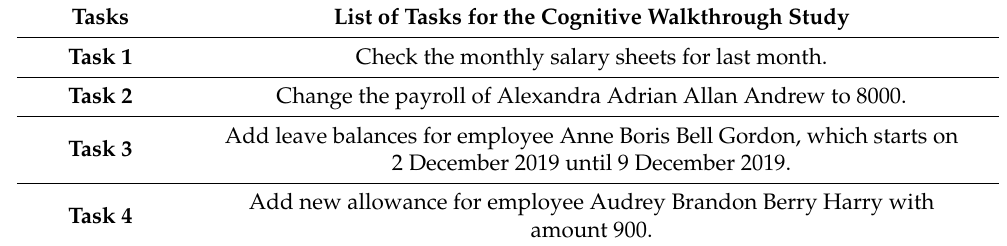
Table 4. Tasks designed for cognitive walkthrough study.